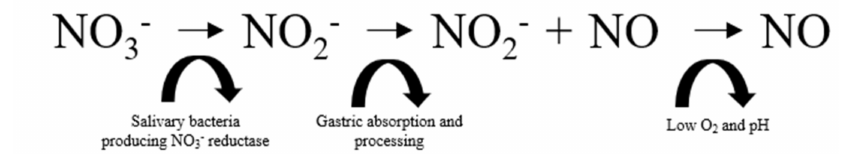
Figure 2. Exogenously regulated NO production pathway that involves the stepwise conversion of inorganic nitrate to nitrite and subsequently nitric oxide. NO 3 − = inorganic nitrate. NO 2 − = nitrite. NO = nitric oxide. O 2 =